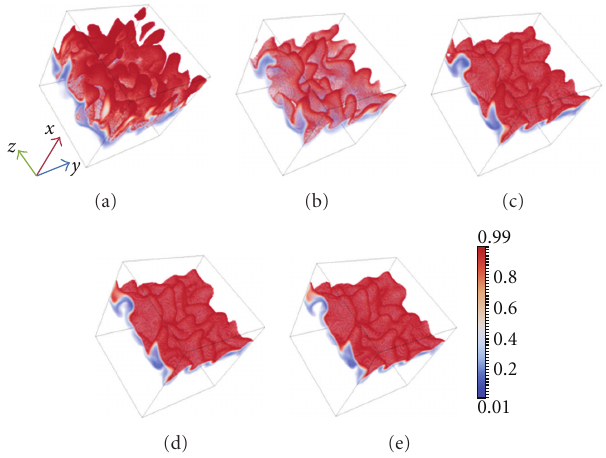
Figure 1: Instantaneous isosurfaces of c ranging from 0.01 to 0.99 at t = 3 t f = t c for cases (a) Le = 0 . 34; (b) Le = 0 . 6; (c) Le = 0 . 8; (d) Le = 1 . 0; (e) Le = 1 . 2. The domain size is 24 . 1 δ th × 24 . 1 δ th × 24 . 1 δ th .